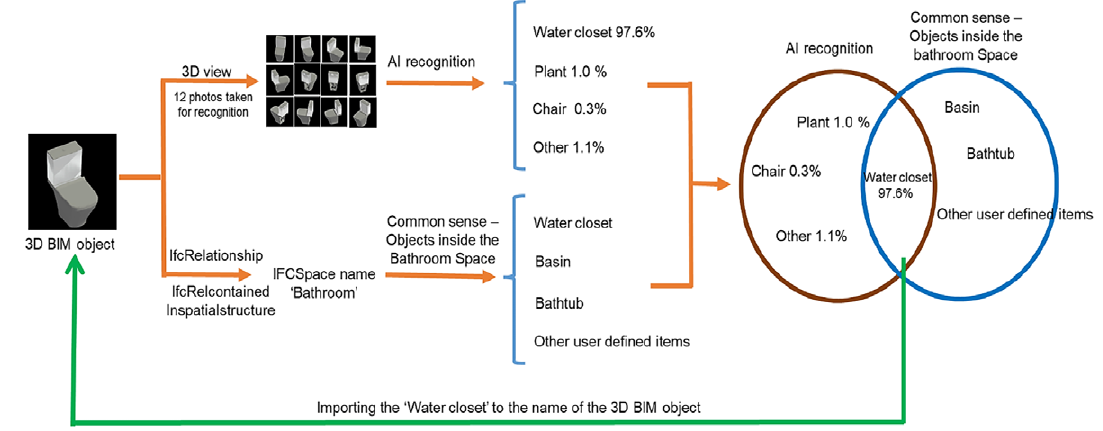
Figure 8. Entire judgment process for 3D BIM object